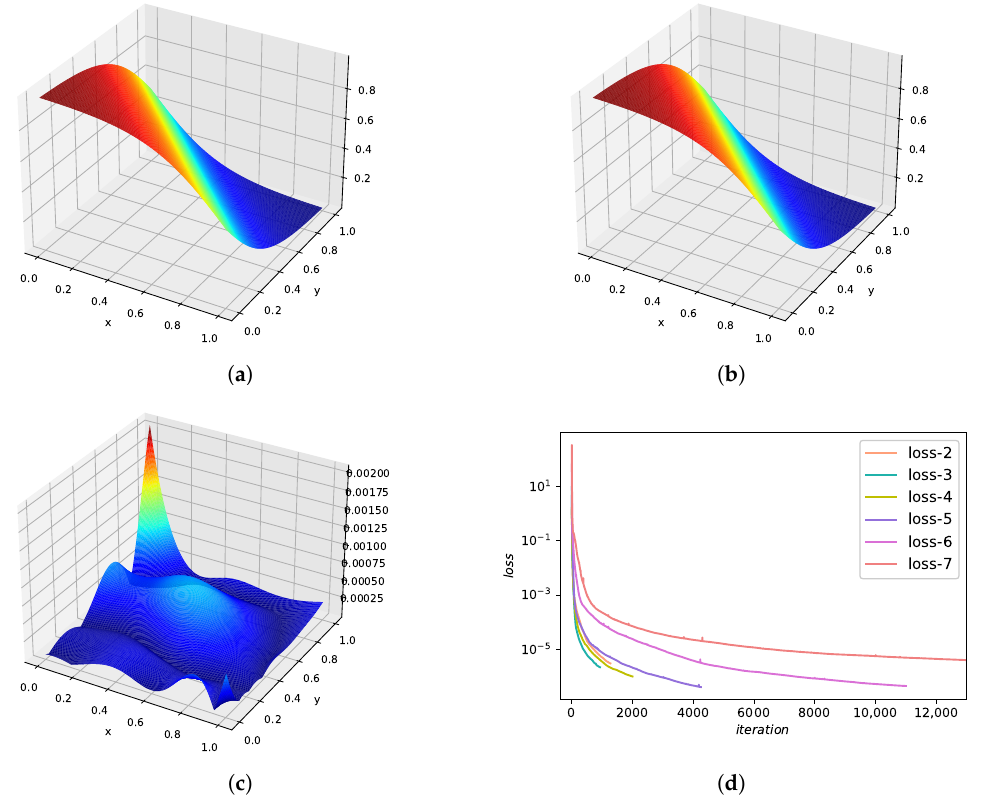
Figure 16. Results of Equation (52). ( a ) Exact solution at time t = 1. ( b ) Predicted solution at time t = 1. ( c ) Numerical error at time t = 1. ( d ) The change process of the objective function versus iteration number. Table 7. The L 2 errors and L ∞ errors for 2D